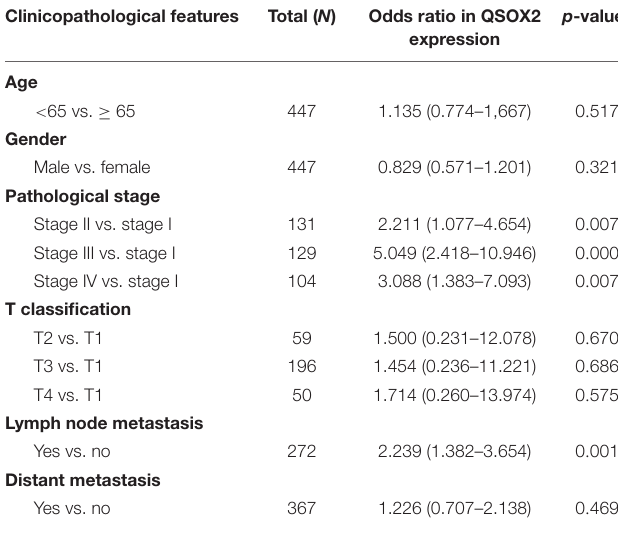
TABLE 4 | QSOX2 expression correlated with clinicopathological features based on TCGA